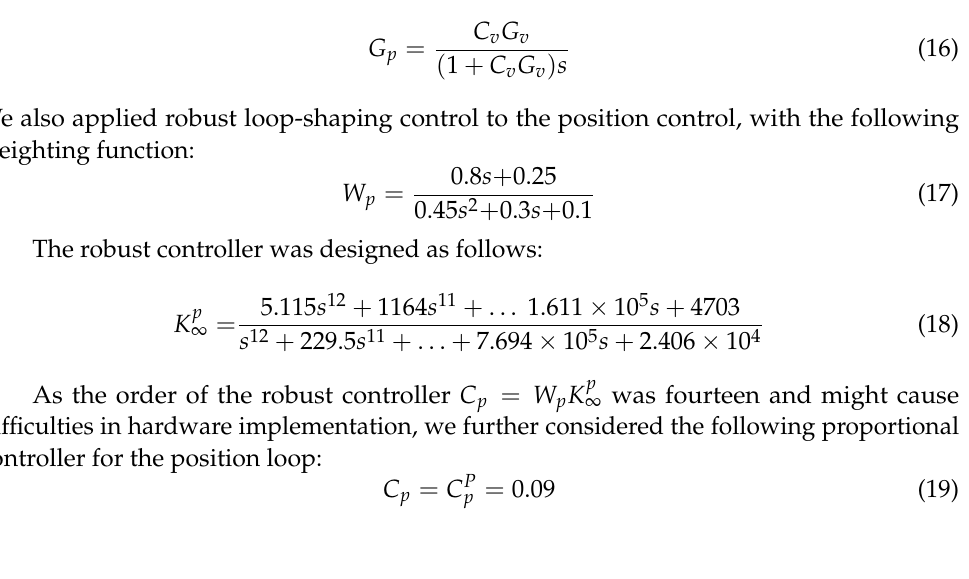
Figure 7. The experimental responses for velocity control: ( a ) Online ψ ref adjustment; ( b ) ψ ( t ) responses; ( c ) control signal V ψ ( t ) ; ( d )Velocity responses v ( t ) ; ( e ) Position responses p ( t ) .